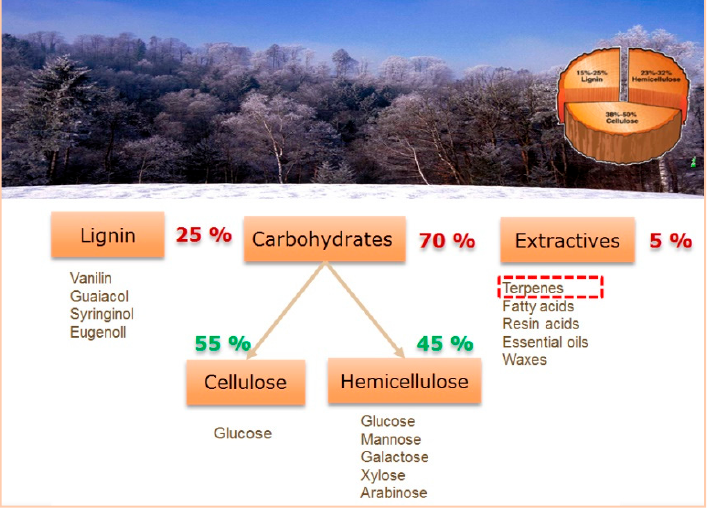
Figure 1. Chemistry of wood.